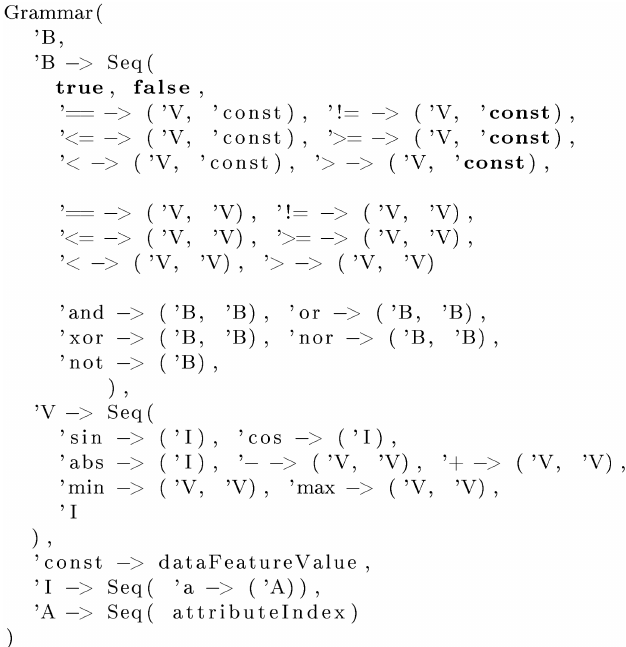
Fig. 6. Modi¯ed grammar describing genes in